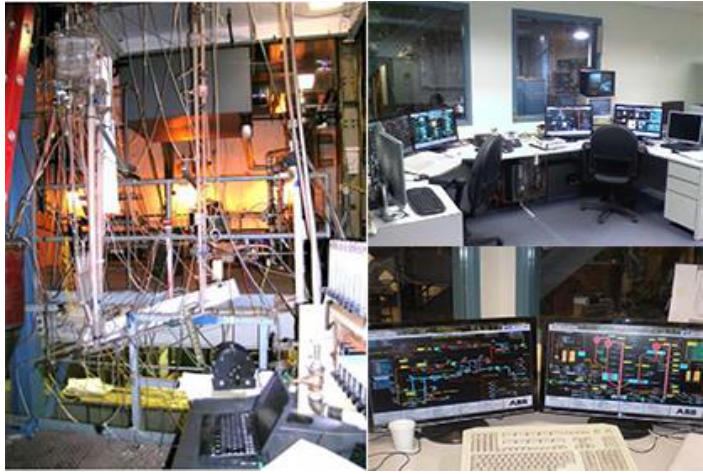
Figure 4. Experimental facility for control testing.